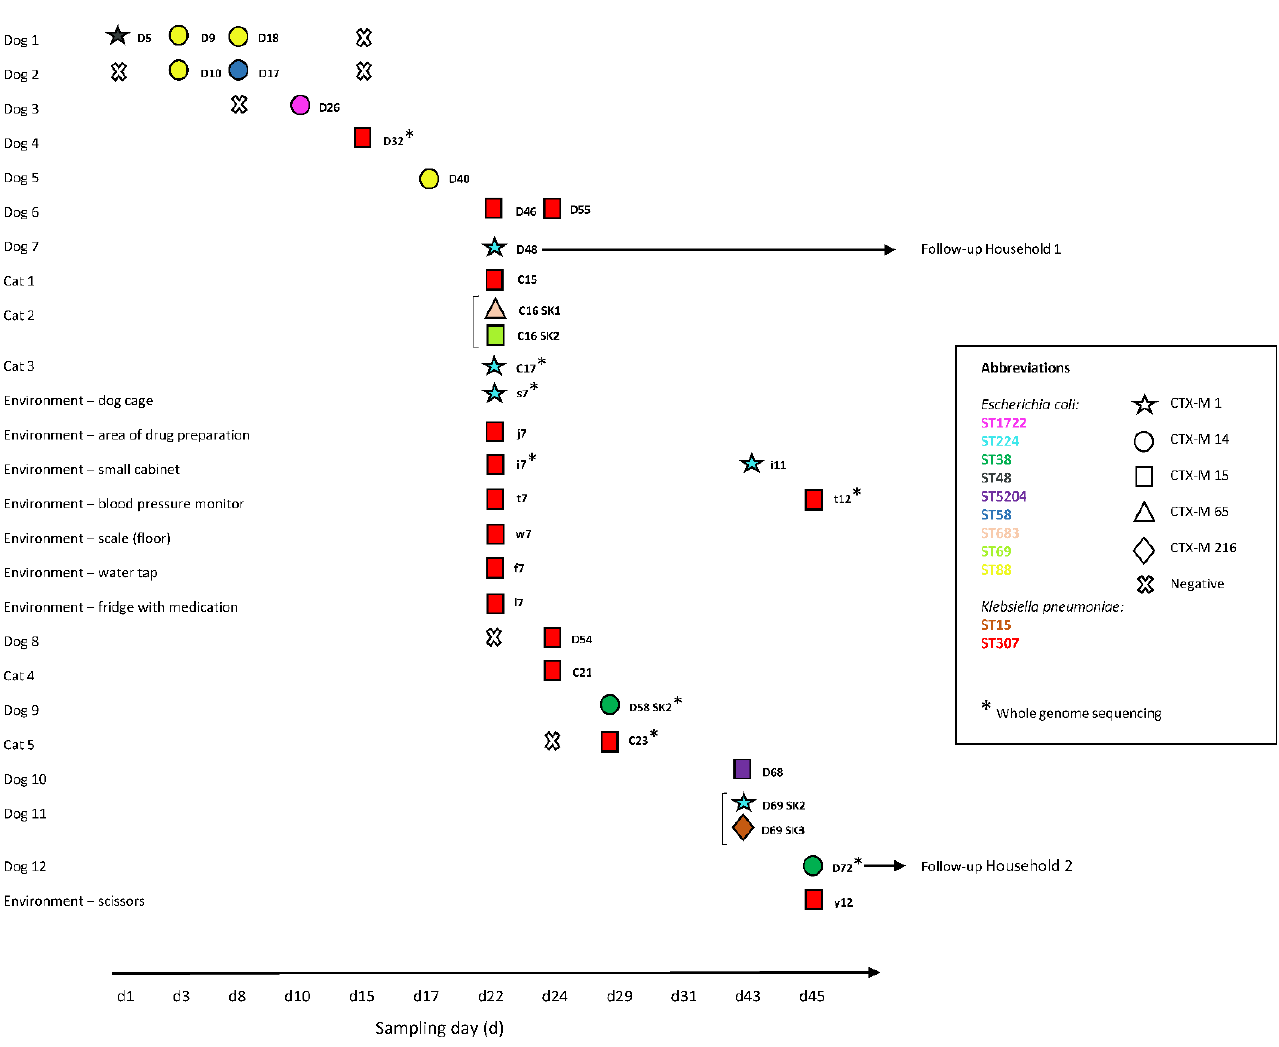
Figure 1. Timeline of extended-spectrum beta-lactamase-producing Enterobacteriaceae (ESBL-E) isolated from dogs, cats and the clinical environment.